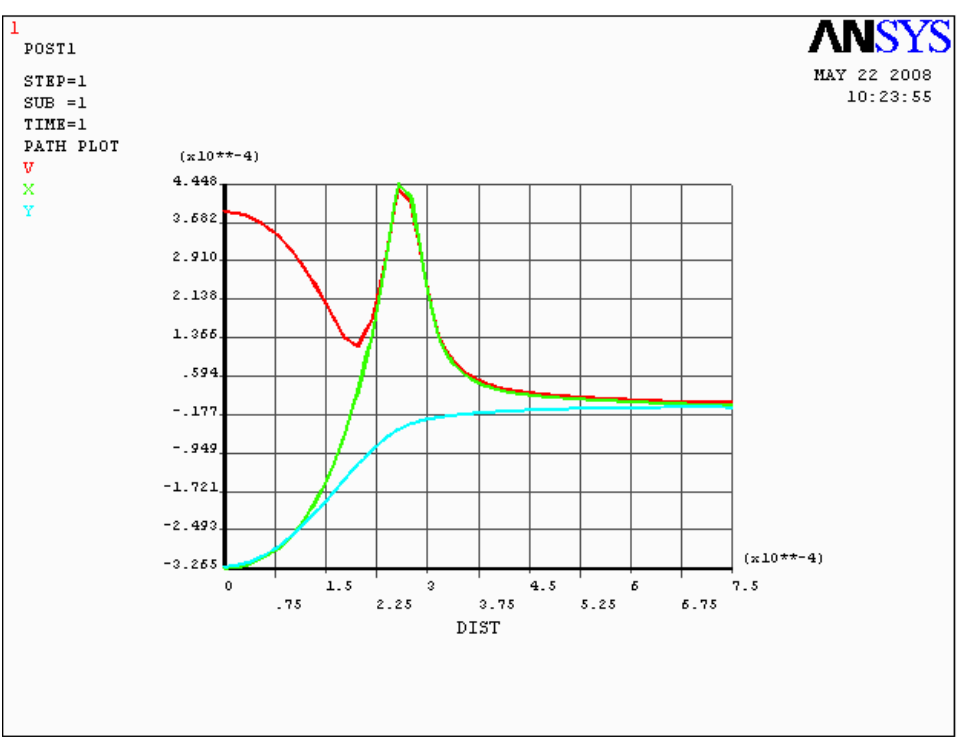
Figure 2. X-direction strain distribution curve, V, X and Y represent the result of von mises, transverse, and longitudinal